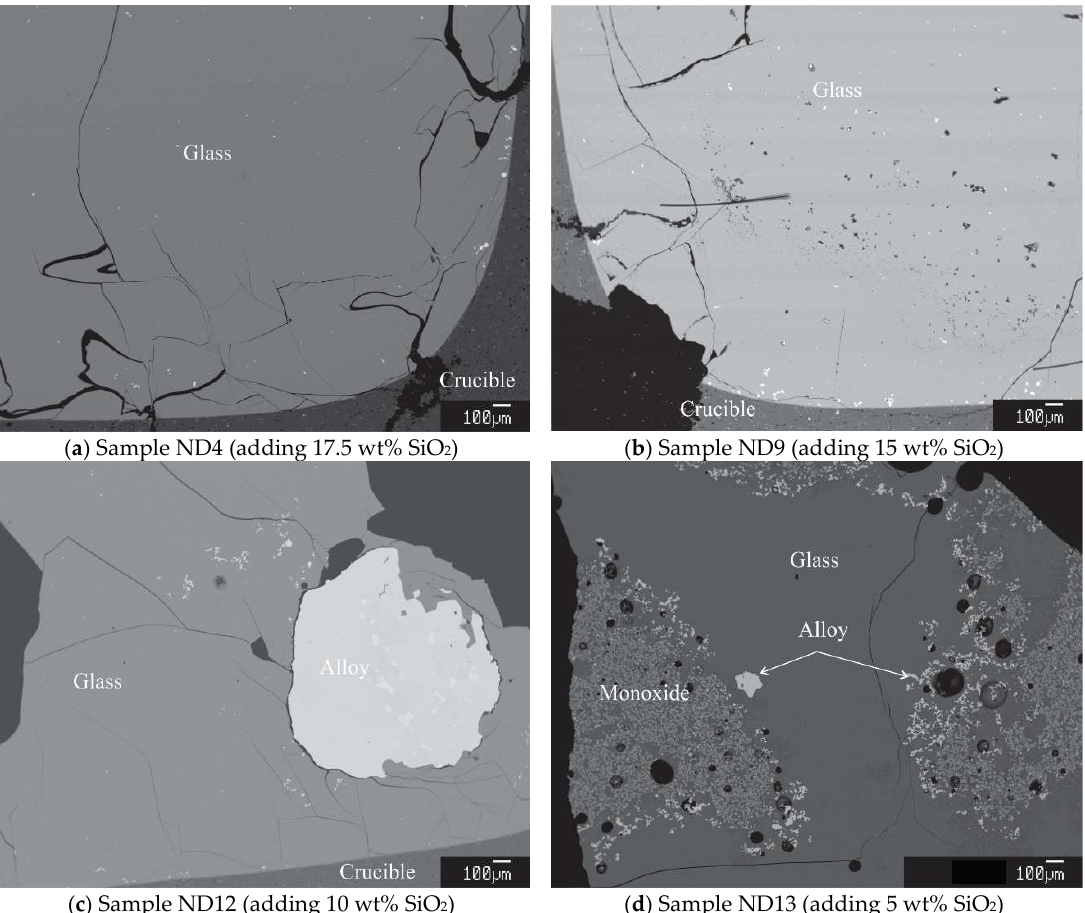
Figure 7. Microstructures of slags of the quenched samples with different SiO 2 addition.